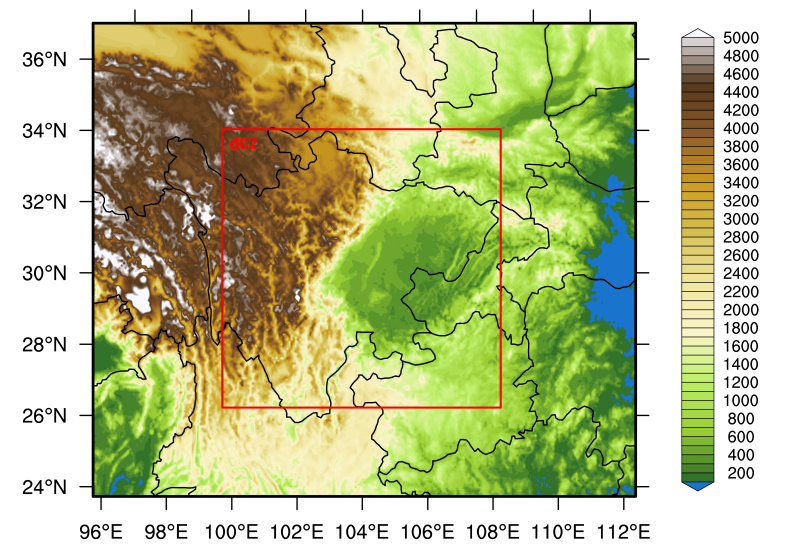
Figure 1. Map showing the parent and a nested domain for the WRF model. Shaded stands for the elevation